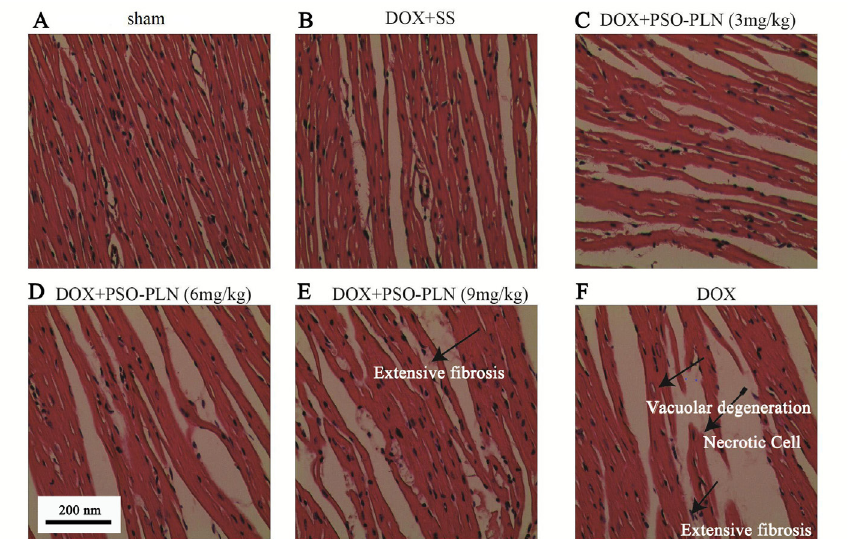
FIGURE 5 - Histological sections of the cardiac tissue on day 21 from mice treated with sham, DOX+SS, DOX + PSO-PLN (3 mg/kg), DOX+PSO-PLN (6 mg/kg), DOX+PSO-PLN (9 mg/kg),